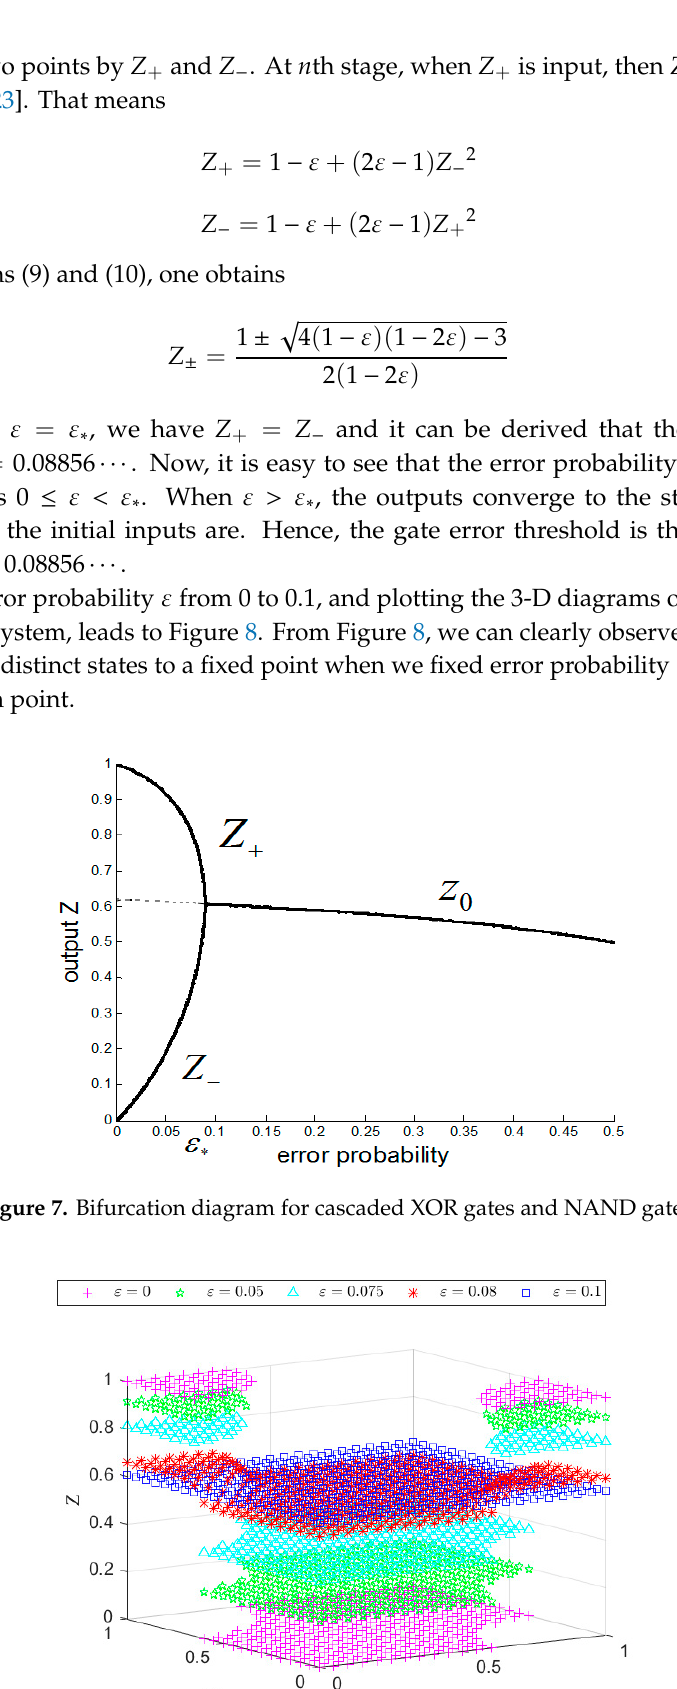
( b ) Figure 9. 3-D diagrams of XOR multiplexing for fixed input Y: ( a ) fixed 0 Y = ; ( b ) fixed